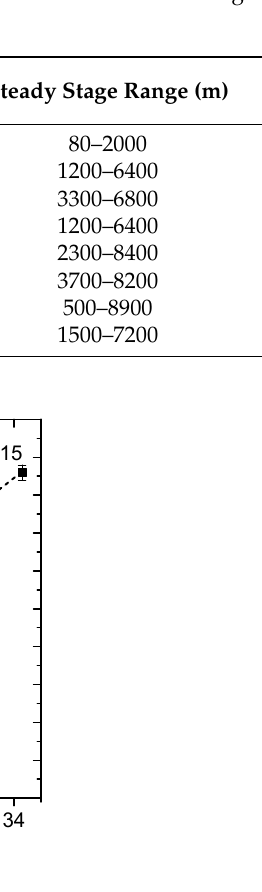
Figure 6. Correlations between hardness and coefficient of friction in the studied HiPIMS W-C:H coatings deposited with different additions of acetylene (full line) and hydrogen (broken line) in the Ar sputtering atmosphere. Shortened abbreviation at the individual data-points identifies the coatings deposited with different flows of C 2 H 2 and H 2 in the Ar sputtering atmosphere.